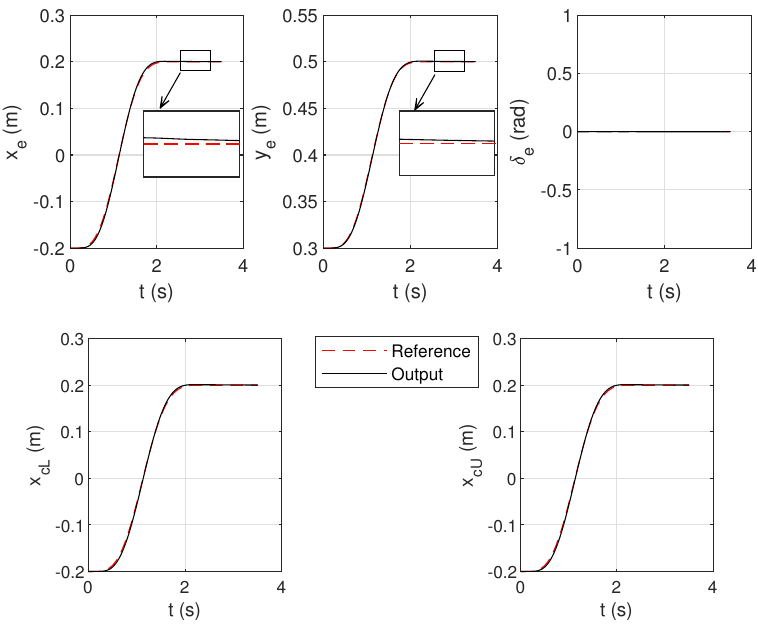
Figure 9. Case I results.